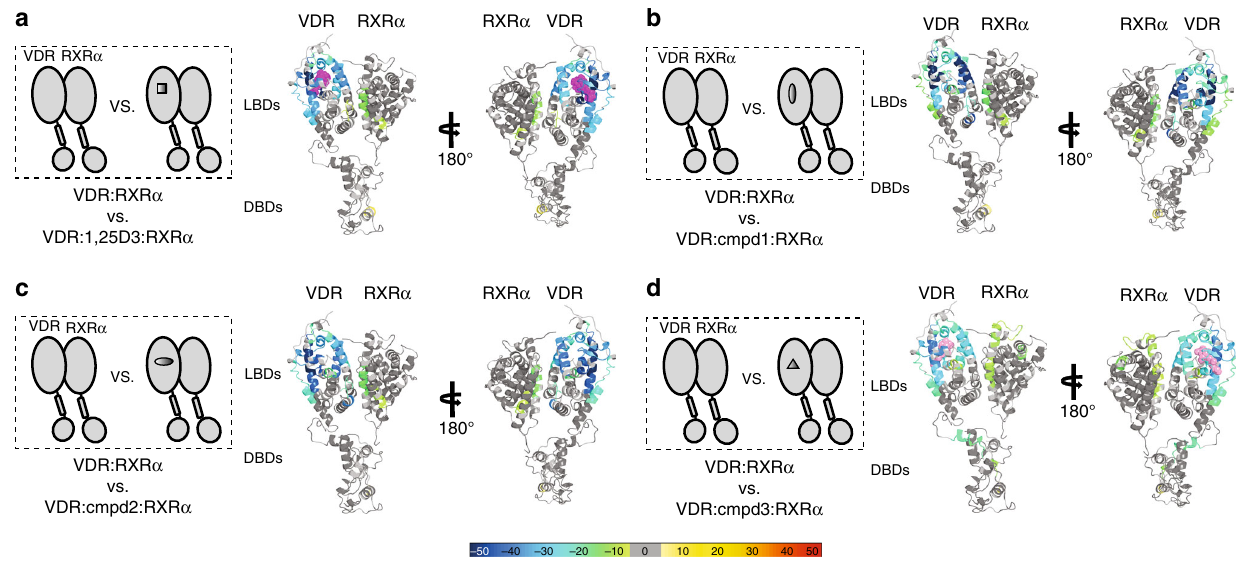
Fig. 2 HDX characterization of ligand binding effects within intact VDRRXR α heterodimer. Schematic representations illustrate differential experiments of VDRRXR α heterodimer verse VDRRXR α : ligand complex (on the left). Differential consolidation HDX data are mapped onto the full-length VDRRXR heterodimer structure model in ribbon (on the right), as shown by representation of altered conformational dynamics of co-receptors upon binding to a natural ligand 1,25D3 (Supplementary Fig. 1b, d, column (i)), b Cmpd1 (Supplementary Fig. 1b, d, column (ii)), c Cmpd2 (Supplementary Fig. 1b, d, column (iii)), and d non-calcemic ligand Cmpd3 (Supplementary Fig. 1b, d, column (iv)). Percentages of deuterium differences are color-coded according to Fig. 1. Dark gray, no statistically signi fi cant changes between compared conditions; light gray, regions that have no sequence coverage and include proline residue that has no amide hydrogen exchange activity; purple, 1,25D3 ligand; pink,